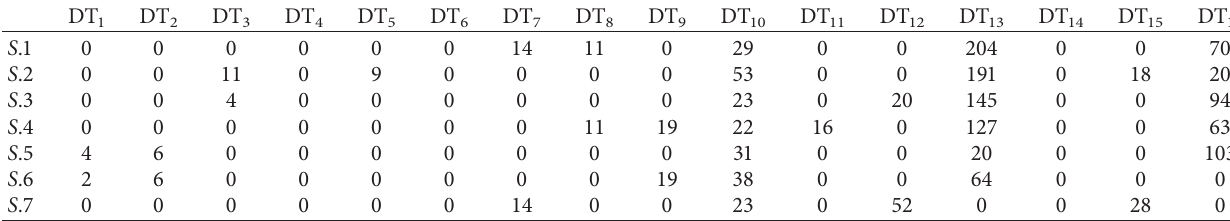
Table 3: The value of DT of partial simulation results for 5 random disruptions.